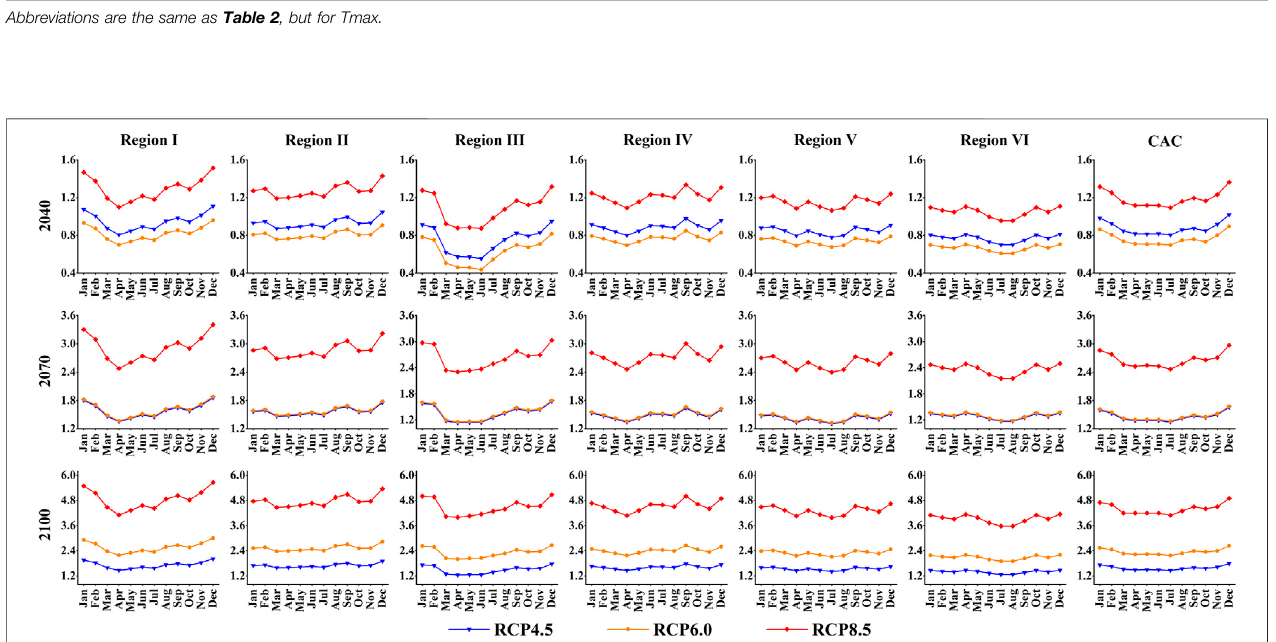
Abbreviations are the same as Table 2 , but for Tmax.